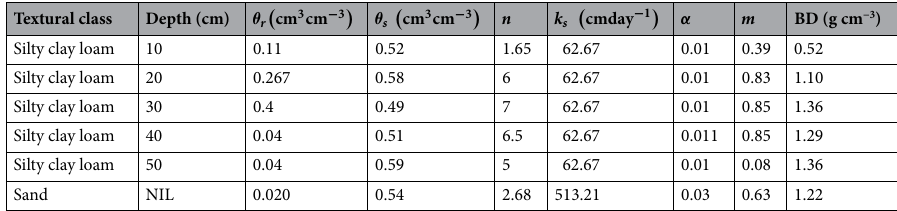
Table 1. Soil textural and soil hydraulic parameters. BD bulk density.